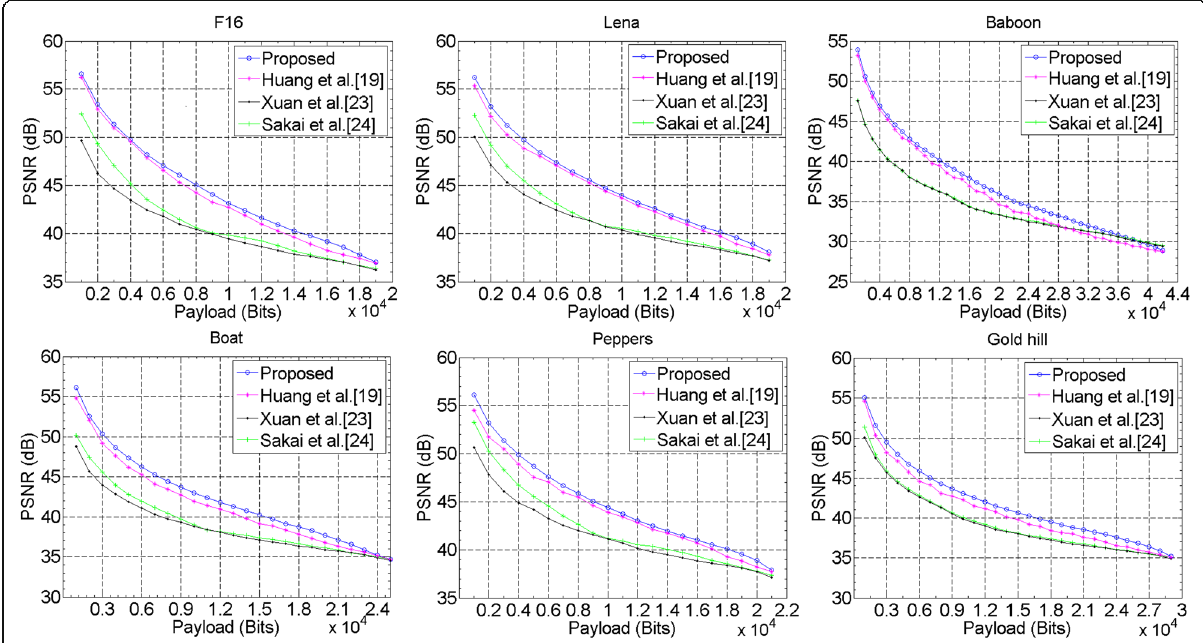
Fig. 6 PSNR comparison of proposed scheme on six different images using four different methods